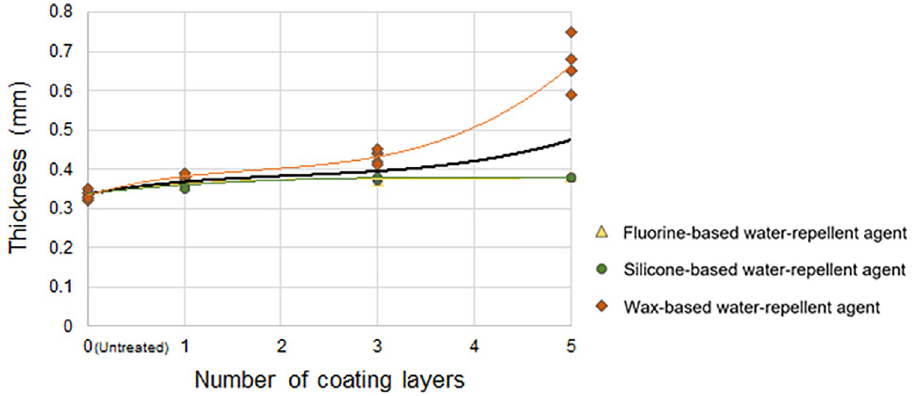
Fig 5. Thickness of the cotton woven fabric according to the number of coating layers of the water-repellent agent. The black line represents the trendline (third-order polynomial).